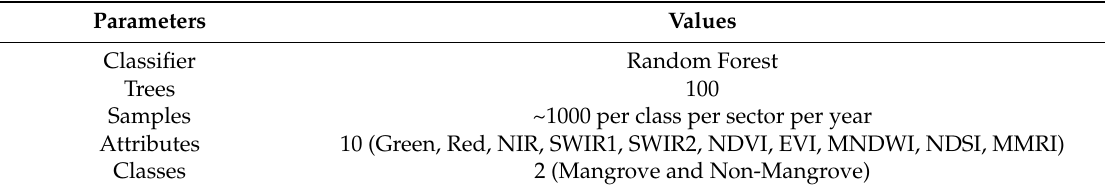
Table 1. Classifier attributes and classification parameters. In total, ten (10) distinct attributes were used. NIR, stands for near-infrared; SWIR1 and SWIR2, short-wave infrareds 1 and 2.